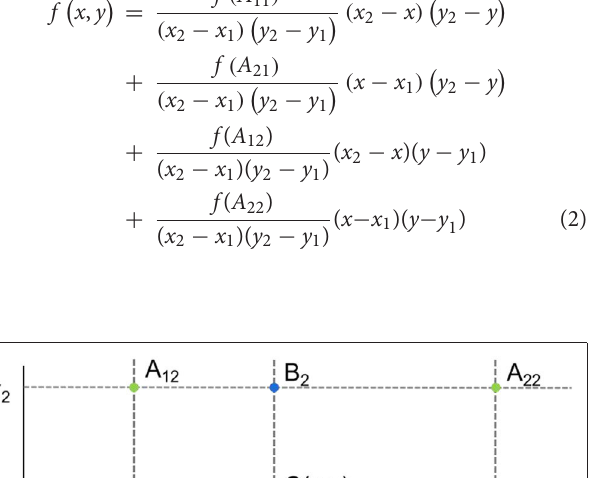
Frontiers in Plant Science |